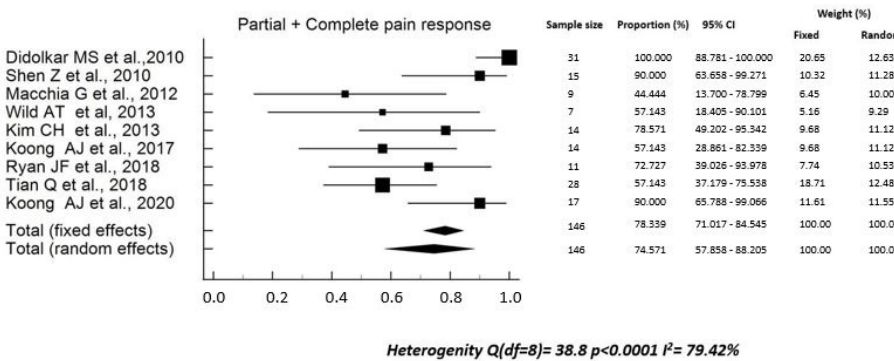
Figure 4. Overall global (complete plus partial) response to pain [18,19,22,23,27,29,31,32,34].